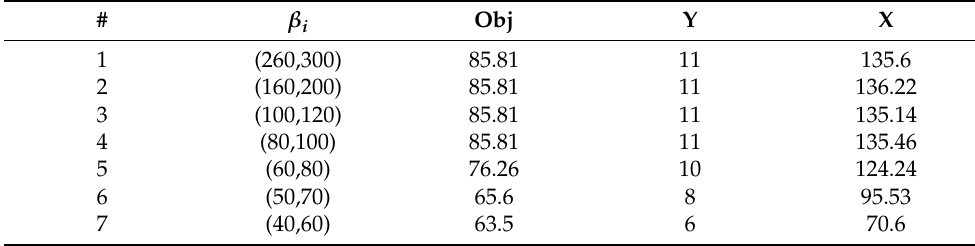
Table 2. Computational results for different values of facility capacity